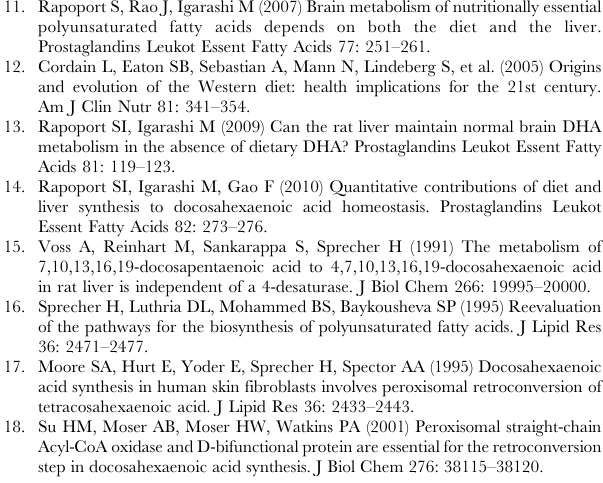
Table S2 List of medications taken by the subjects involved in the liver